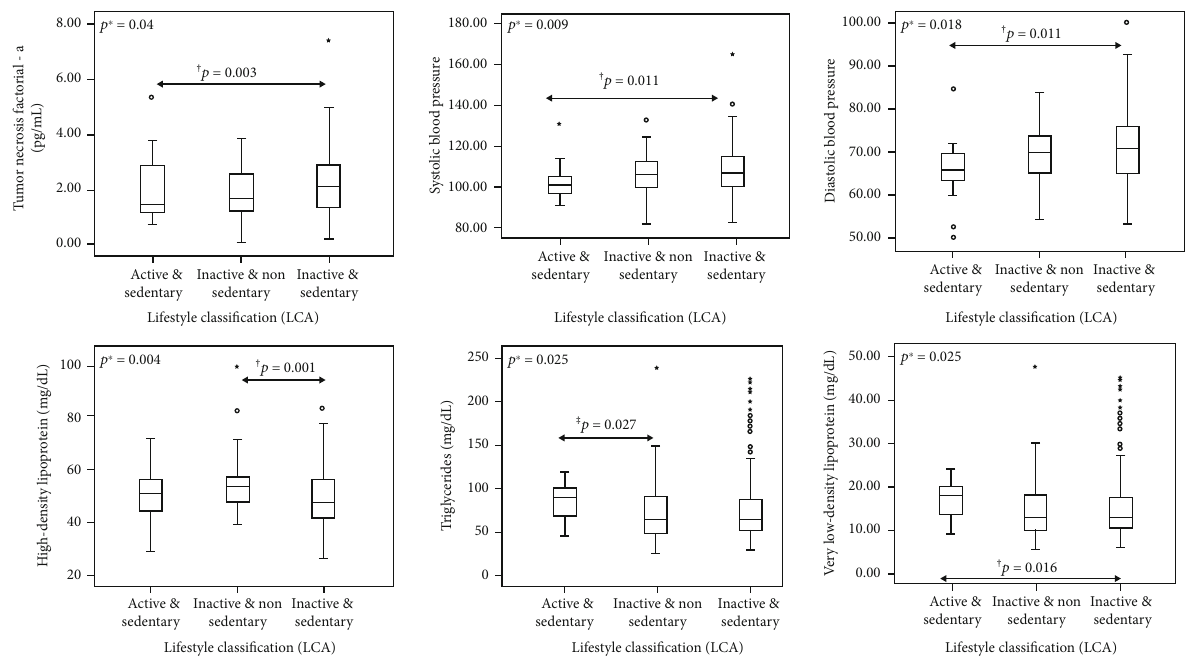
Figure 2: Signi fi cant di ff erences on cardiometabolic disease risk factors and in fl ammatory markers among the latent classes that represent the adolescents ’ lifestyle. ∗ Signi fi cant p values ( p < 0 : 05 ) of Kruskal-Wallis test; † signi fi cant p values of Mann-Whitney test after Bonferroni correction ( ≤ 0.0166) between groups 1 and 3; ‡ nonsigni fi cant p values of Mann-Whitney after Bonferroni correction ( > 0.0166) between classes 1 and 2. LCA: Latent Class